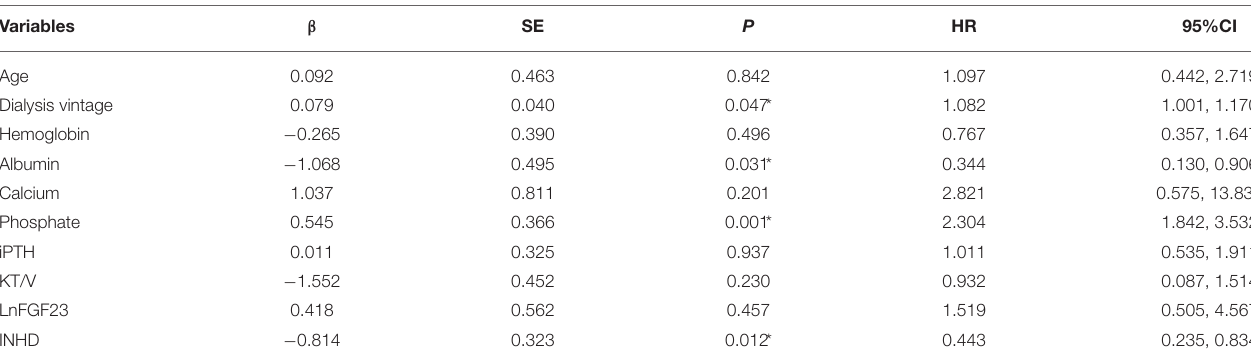
TABLE 6 | Cox regression analyses of factors predicting all-cause mortality.